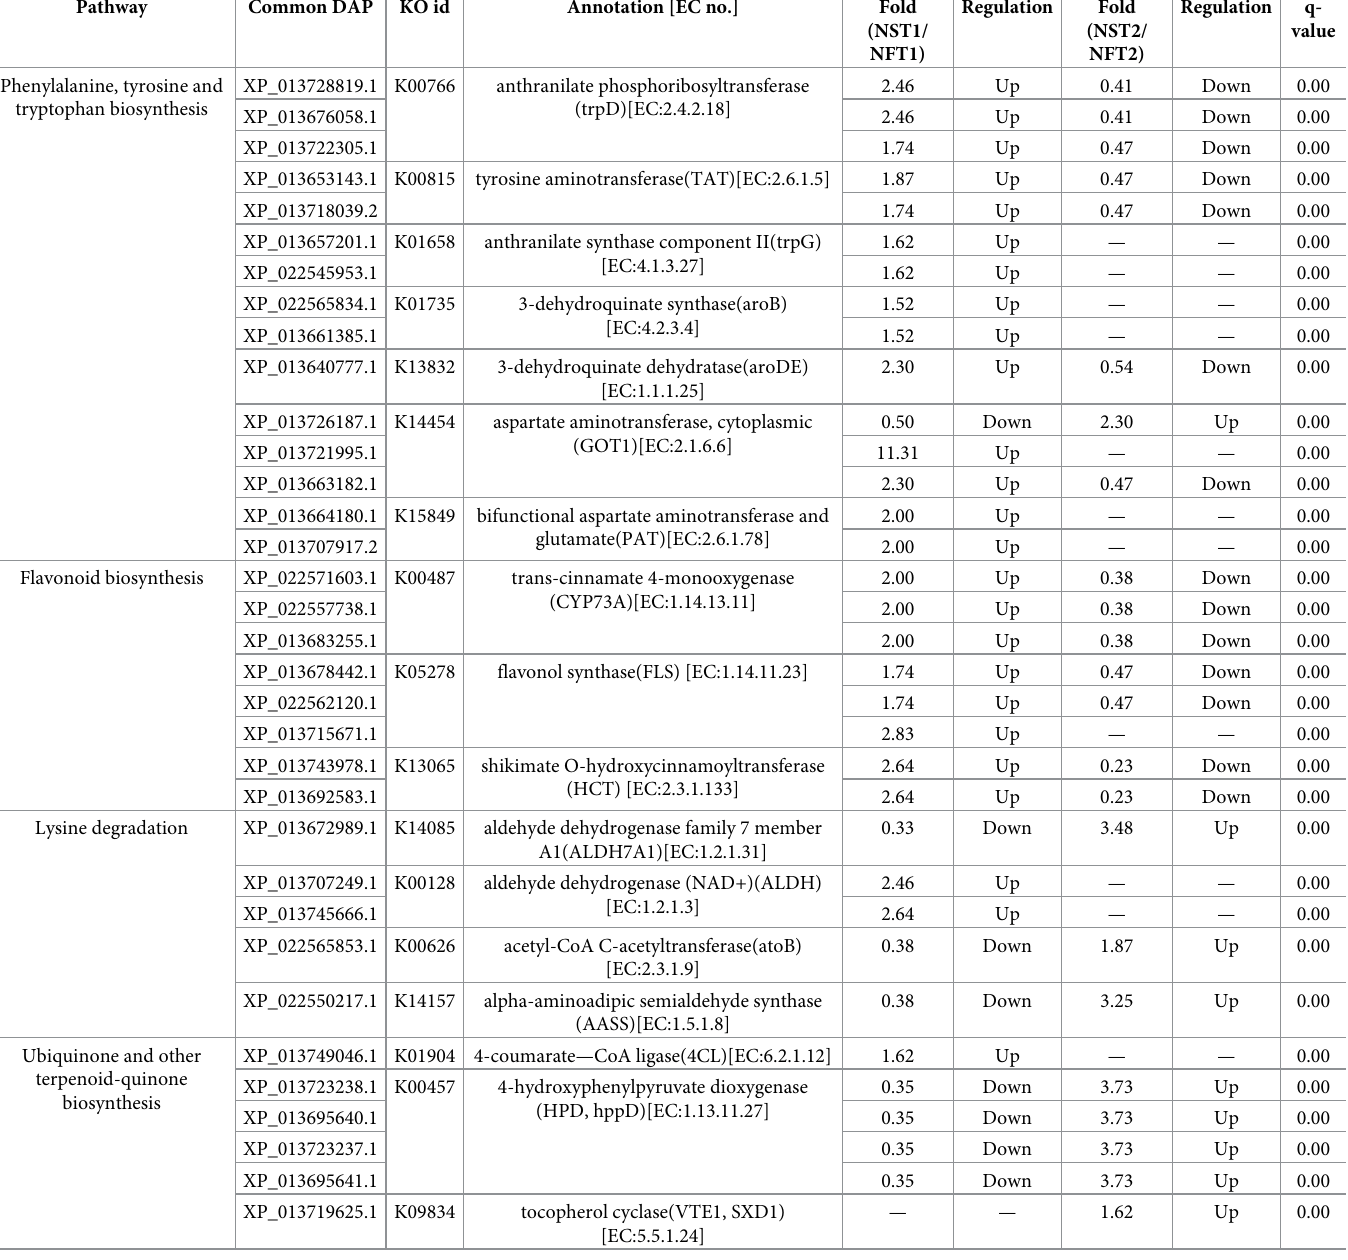
Table 1. Candidate proteins from the four pathways associated with cold tolerance of winter rapeseed. Pathway Common DAP